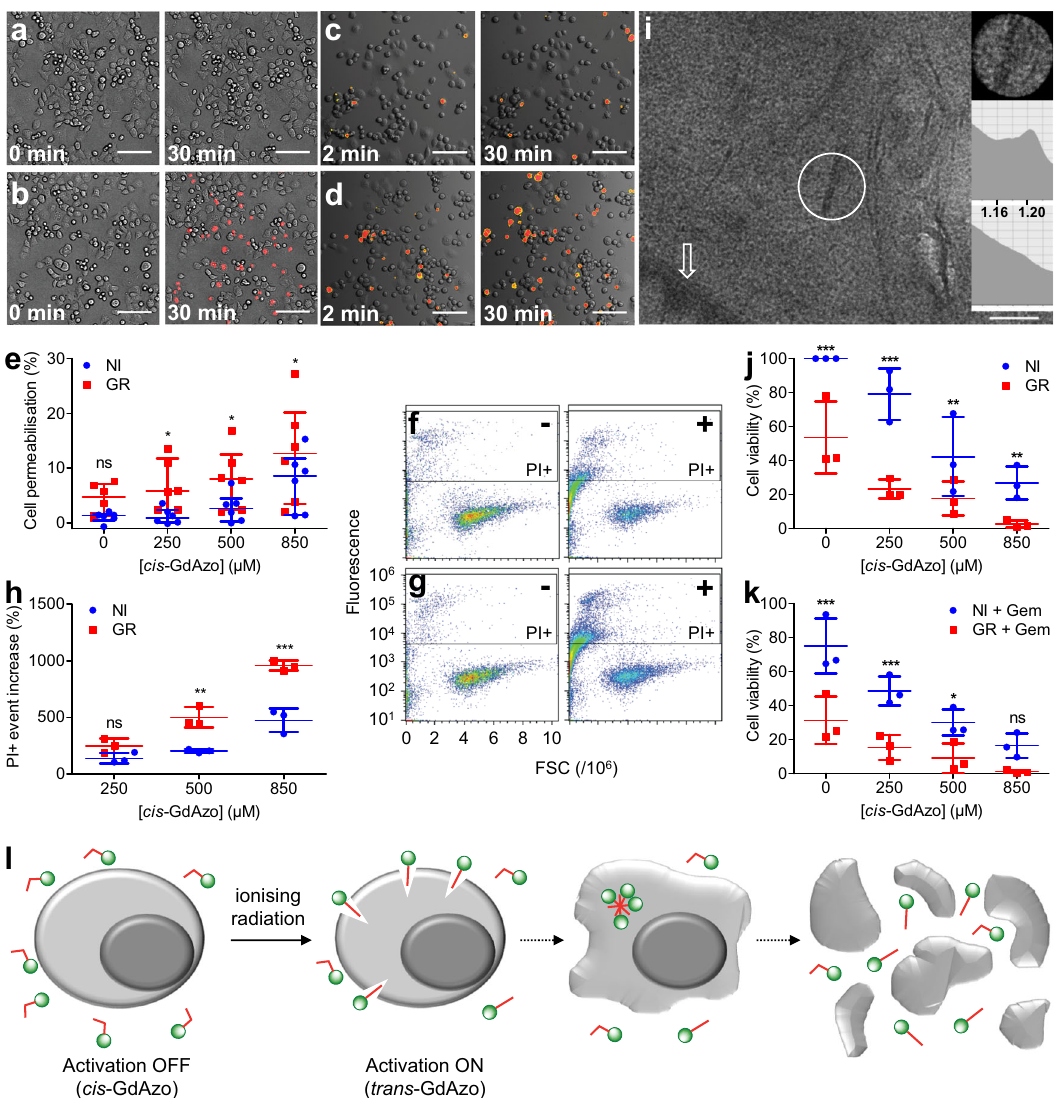
Fig. 7 Cell cytotoxicity triggered by cis -GdAzo activation upon IR. a , b Confocal microscopy of cancer cell (PANC-1) in the presence of PI before (0 min) and 30 min after incubation with either inactive cis - GdAzo ( a ) or active trans - GdAzo ( b ) (4 repetitions, permeabilised cells in red). c , d Confocal microscopy of cancer cell (PANC-1) in the presence of PI at 2 min and 30 min after cis - GdAzo introduction followed by GR ( d ) or no ( c ) irradiation (permeabilised cells in red). e Quanti fi cation of cell permeabilisation (PANC-1) by confocal microscopy after treatment with cis - GdAzo upon GR ( n = 6 biologically independent samples, processed by a custom script, t -values = 3.110, 2.941, 2.815 at 250, 500, 850 µ M). The medians ± interquartile ranges are reported. f , g , Flow cytometry of cancer cells (CCRF-CEM-ARAC-8C) in the presence of PI and cis - GdAzo (absence (-) or 500 µ M ( + )) upon GR ( g ) or without ( f ) irradiation at 30 min post-treatment. h Quanti fi cation of cell permeabilisation (CCRF-CEM-ARAC-8C) by fl ow cytometry after treatment with cis - GdAzo upon GR at 30 min post-irradiation ( n = 3 biologically independent samples, t -values = 5.254, 8.565 at 500, 850 µ M). The relative increase in PI-positive events compared to medium without cis - GdAzo is represented. i , EELS-TEM on cancer cell (PANC-1) in the presence of trans - GdAzo . Gd was detected in localised cytoplasmic areas (circle, top EELS spectrum, keV axis unit) and not in the surrounding cytoplasm (bottom EELS spectrum), cell membrane or nucleus (arrow). j , k Cell viability of Gem-resistant cancer cells (CCRF-CEM-ARAC 8 C) 4 days after treatment with cis - GdAzo upon GR in the absence ( j ) or presence ( k ) of Gem ( n = 3 biologically independent samples, t -values = 6.854, 8.258, 3.636, 3.557 at 0, 250, 500, 850 µ M in the absence of Gem and 6.454, 4.927, 3.099 at 0, 250, 500 µ M in the presence of Gem). l Representation of the impact of cis - GdAzo on cancer cells upon IR as assumed from the microscopy experiments. The means ± standard deviations are reported unless otherwise speci fi ed. Two-way Anova (Bonferroni post-test) was used for statistical analyses (NI vs GR). ns: not signi fi cant, * P < 0.05, ** P < 0.01, *** P < 0.001. Scale bars = 125 µ